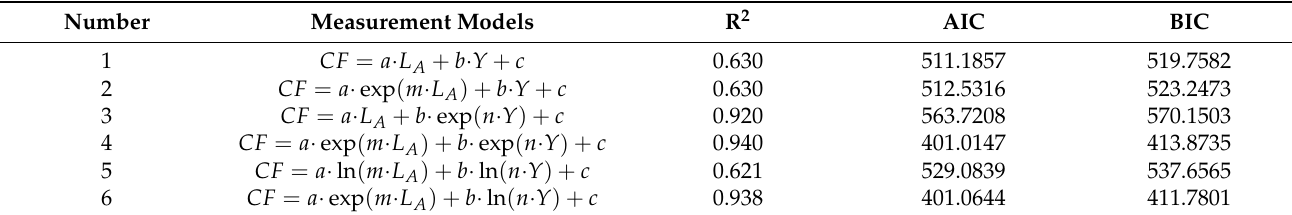
Table 1. Comparison between various measurement models for carbon dioxide emission factors. Number Measurement